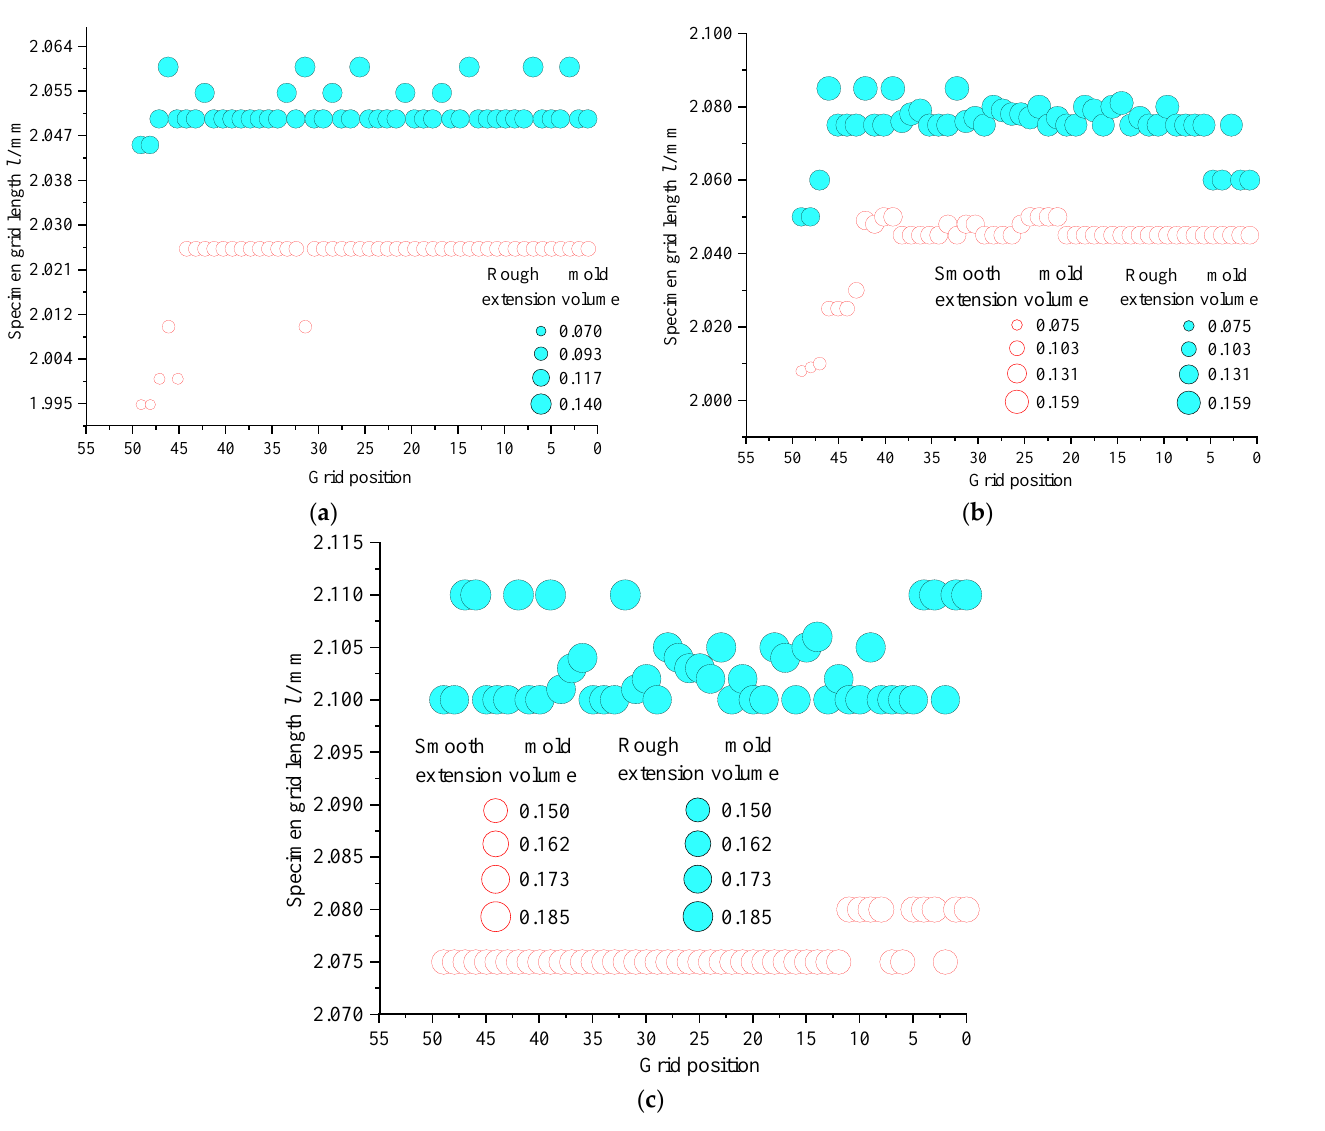
Figure 17. Strain grid length and deformation distribution of suspension segment. ( a ) 30° contact mold; ( b ) 45° contact mold; ( c ) 60° contact mold.